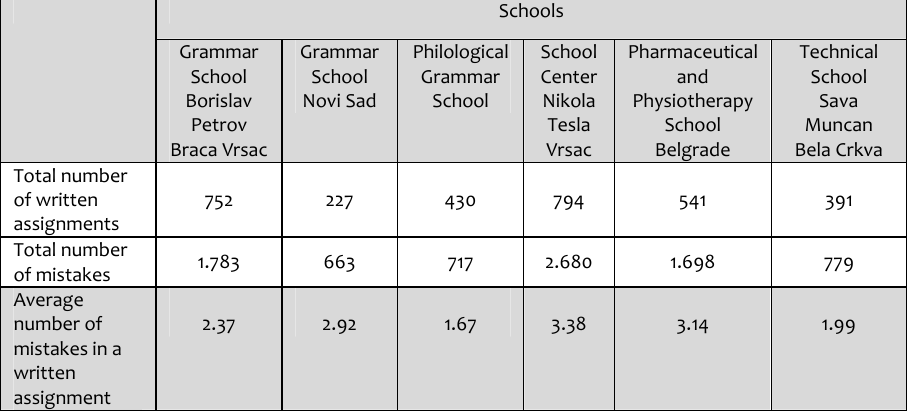
Table 5: The average of and the total number of orthographic mistakes in the written assignments of secondary school students with the respect to the schools that students attend